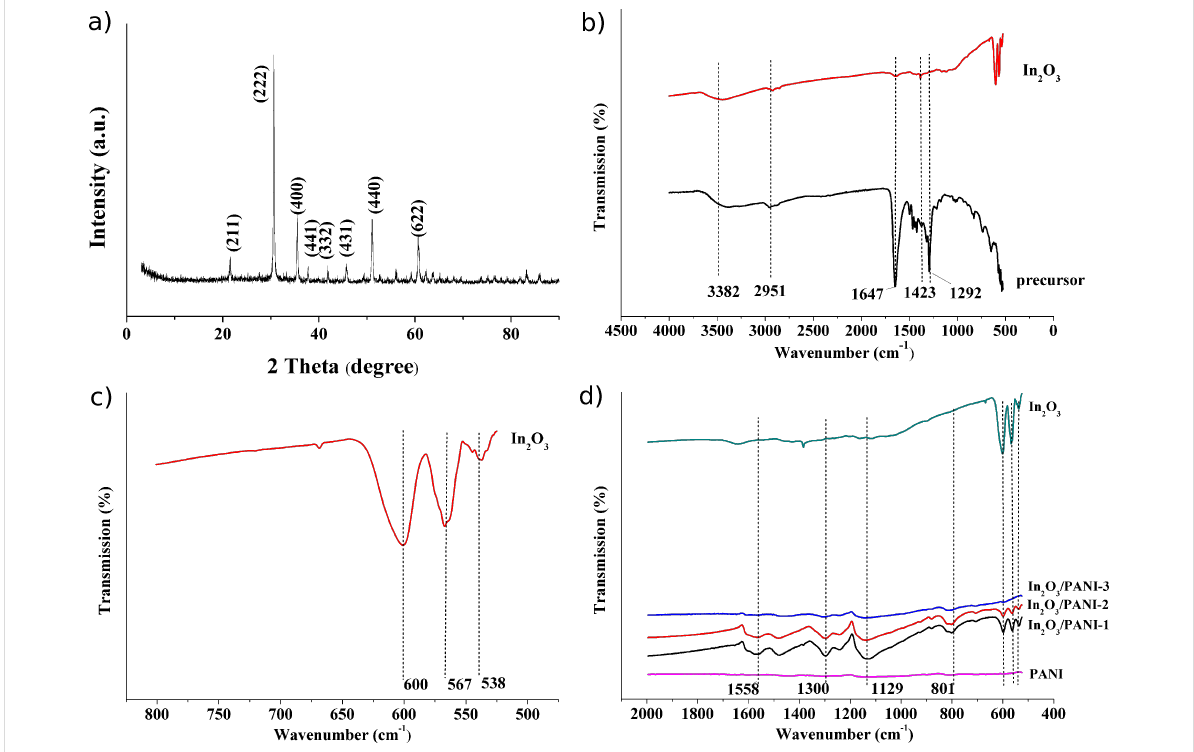
Figure 2: a) XRD pattern of In 2 O 3 nanofibers. FTIR spectra of b) In(NO 3 ) 3 /PVP composite nanofibers and In 2 O 3 nanofibers, c) In 2 O 3 nanofibers, and d) In 2 O 3 nanofibers and In 2 O 3 /PANI composite